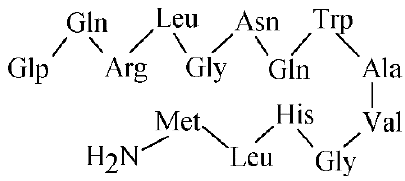
Figure 13. The AA sequence of bombesin peptide.